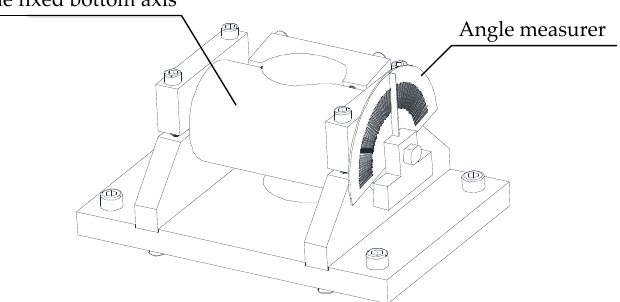
Figure 5. Multi-angle mounting base.